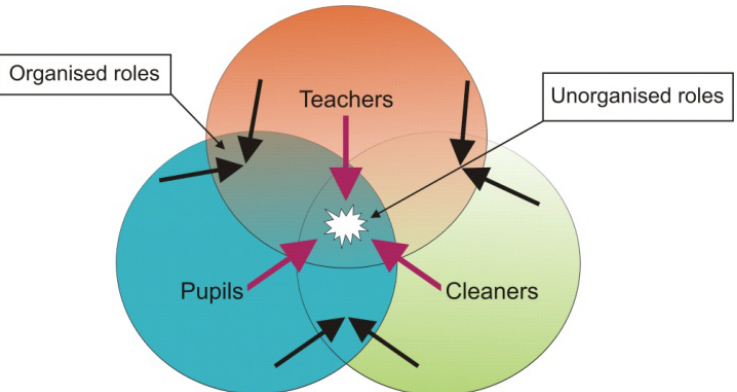
Figure 2. Crossing spaces and tasks among the cleaners, teachers, and